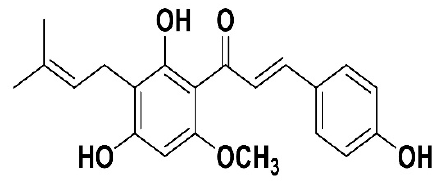
Figure 1. Structure of Xanthohumol.